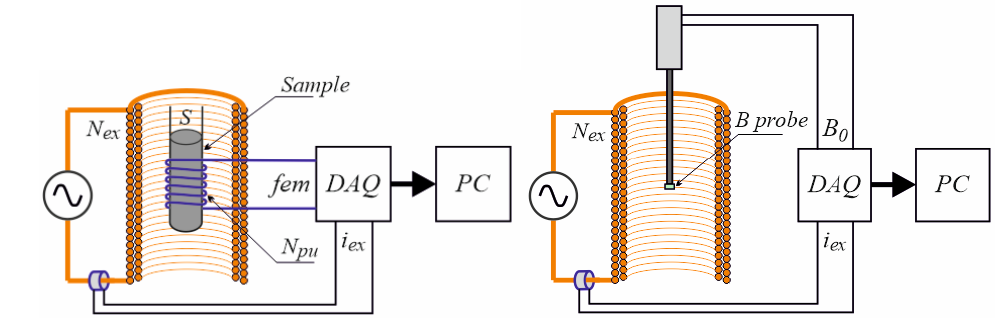
Figure 9. Setups to determine the magnetic susceptibility of carbons as B HC ( left ) and B 0 ( right ).